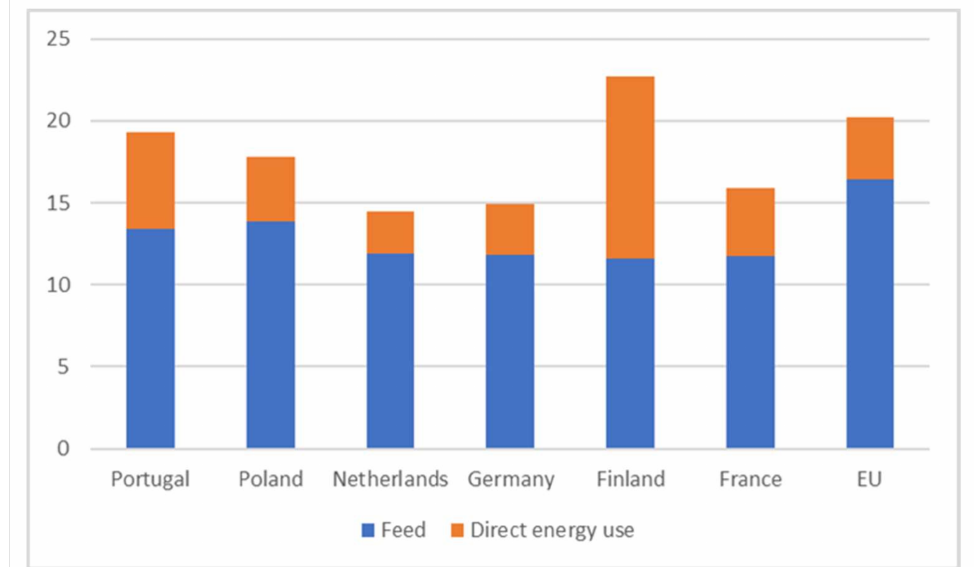
Figure 5. Energy inputs for pig production slaughter weight MJ/kg (based on [13,14,21]).